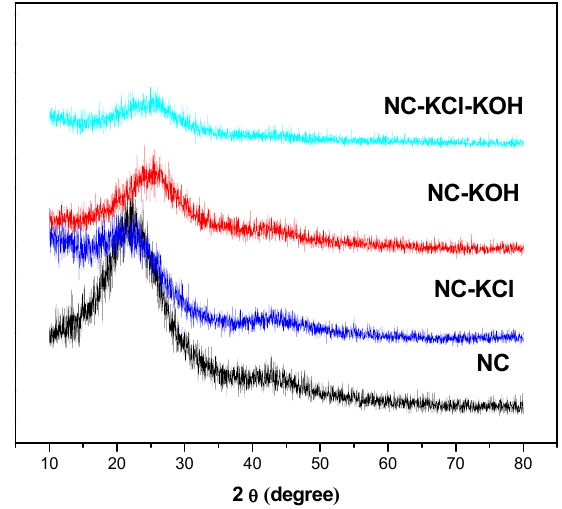
ff raction patterns of typical samples. Figure 10. X-ray diffraction patterns of typical samples. Figure 10. X-ray di